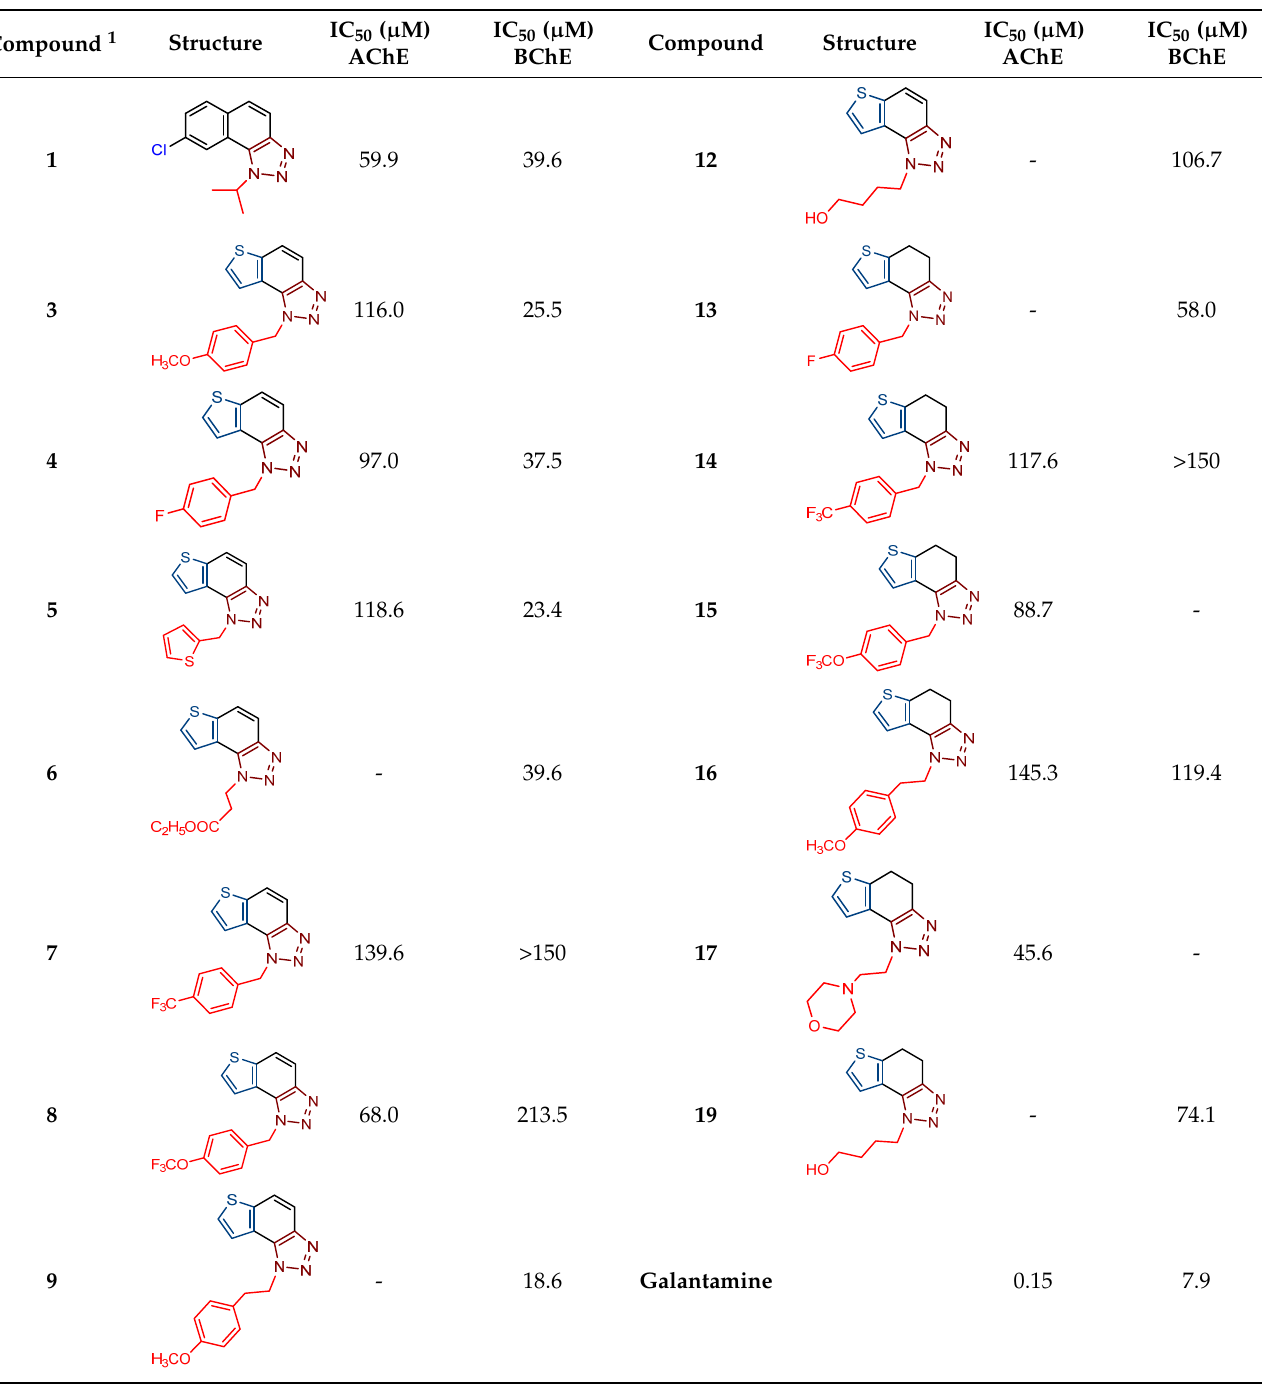
Table 1. Calculated IC 50 values for compounds 1 – 19 .